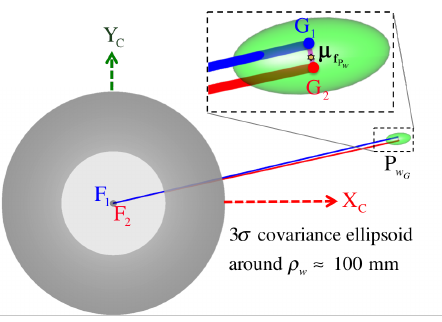
Figure 18. Top-view of the three-sigma level ellipsoid for the triangulation uncertainty of a pixel pair